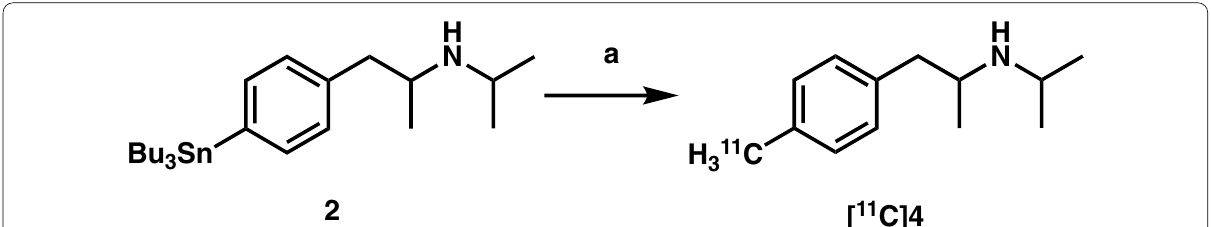
Fig. 2 Synthesis of N -isopropyl- p -[ 11 C]methylamphetamine ([ 11 C] 4 ). Reagents and conditions: ( a ) [ 11 C]MeI, Pd 2 (dba) 3 , ( o -Tol) 3 P, K 2 CO 3 , CuCl, DMF, 100 °C, 5